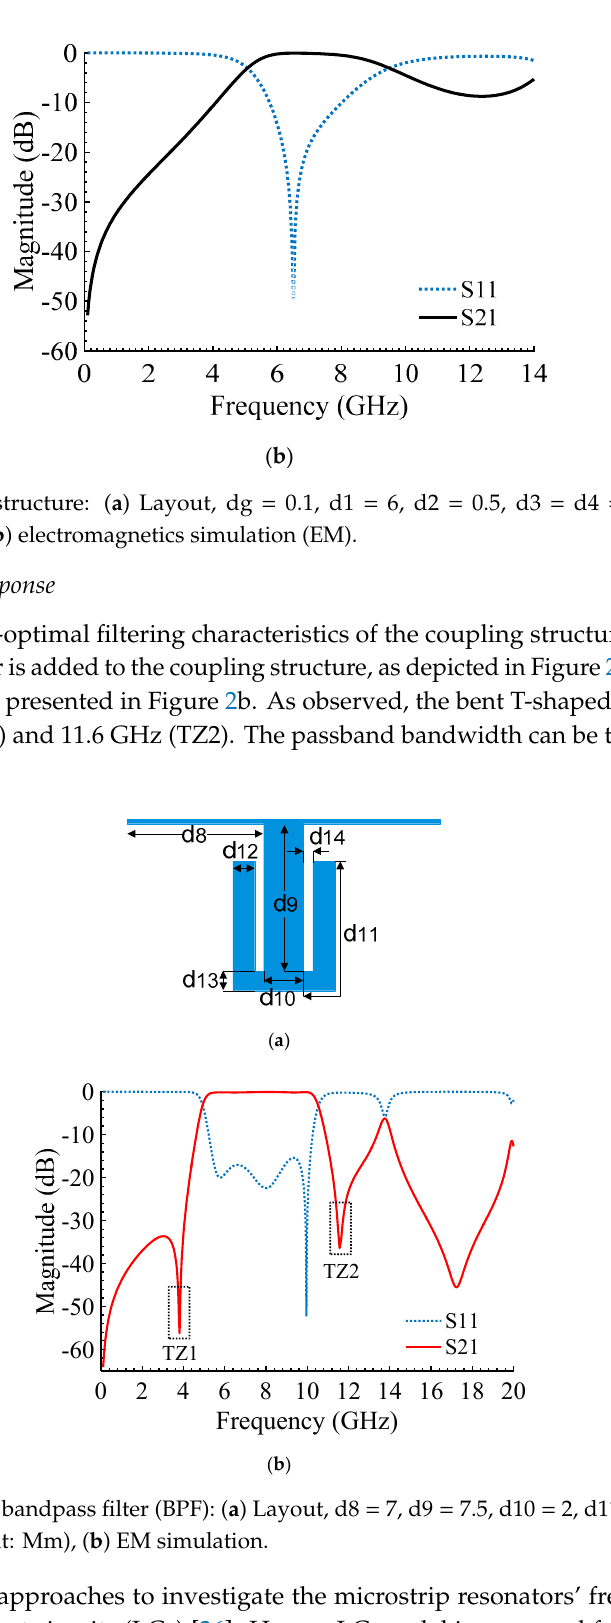
Figure 2. Single-band bandpass filter (BPF): ( a ) Layout, d8 = 7, d9 = 7.5, d10 = 2, d11 = 8.2, d12 = 1.1, d13 = 1, d14 = 0.5 (unit: Mm), ( b ) EM simulation.